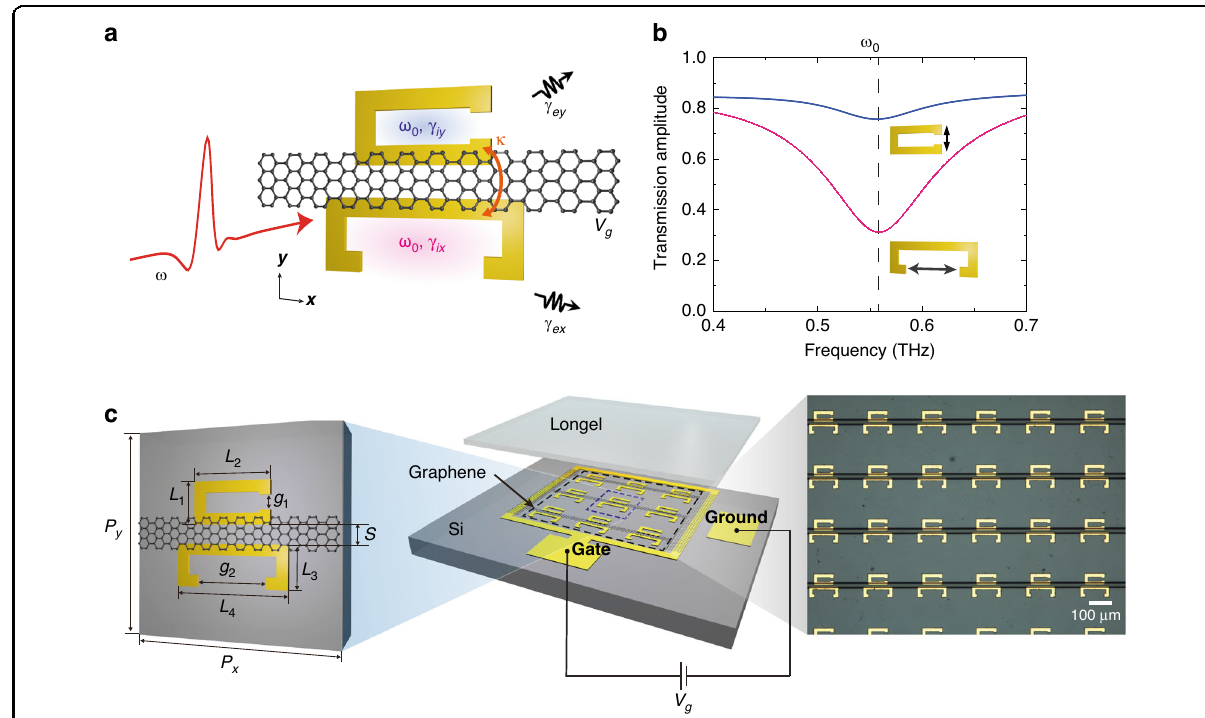
Fig. 1 Design and fabrication of non-Hermitian gated graphene metasurfaces. a Schematic illustration of the unit cell and its interaction with an incident wave. The unit cell is composed of two orthogonally oriented SRRs with an identical resonance frequency of ω 0 , distinct intrinsic and external loss rates of γ i μ and γ e μ ( μ = x,y ), and a coupling strength κ . The two SRRs are bridged by a transferred single-layer graphene microribbon. b Simulated transmission amplitude through each SRR in the absence of the other SRR. The SRRs are excited by an incident wave polarised along the ¼ 0 : 53 ´ 10 12 rad s -1 and γ = 0.03 × 10 12 rad s -1 , respectively. c Schematic rendering and gap opening. The fi tted external loss rates are γ ey ex microscopic image of the non-Hermitian gated graphene metasurface. The geometric dimensions of the unit cell are set to L 1 ¼ 24 μ m, L 2 ¼ 44 μ m, graphene microribbons, a square-ring-shaped gate electrode, a ground electrode and an iongel layer are incorporated into the non-Hermitian graphene metasurface. Here, two ends of the graphene microribbon are attached to the square-ring-shaped electrode, while the iongel layer covers both the gate and ground electrodes as well as the array of graphene